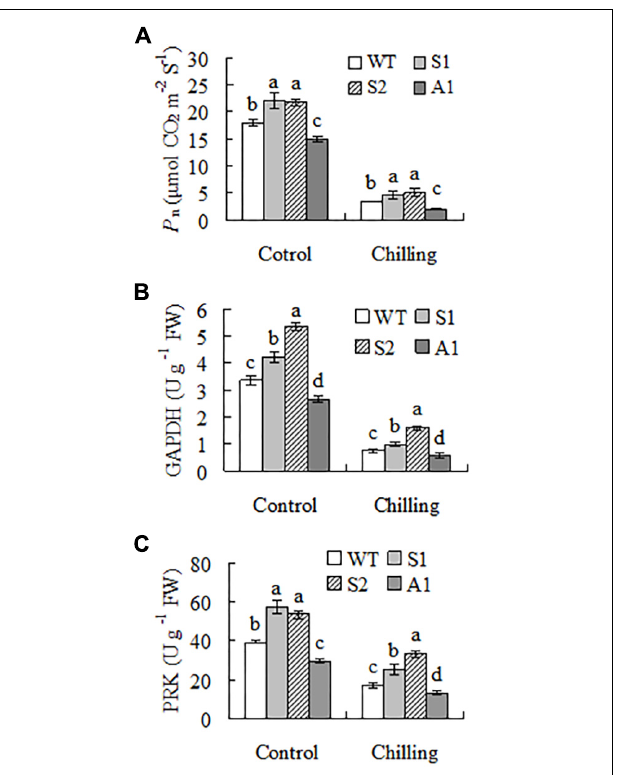
FIGURE 6 | Net photosynthetic rate ( P n ) and enzyme activities of carbon assimilation in transgenic plants overexpressing SgCP12 or down-regulating SgCP12 expression in comparison with the wild type ( S . guianensis cv. CIAT184). P n (A) and activities of GAPDH (B) and PRK (C) were measured before chilling treatment or 8 d after chilling treatment at 6 ◦ C. Means of three replicates and standard errors are presented; the same letter above the column indicates no significant difference at P <